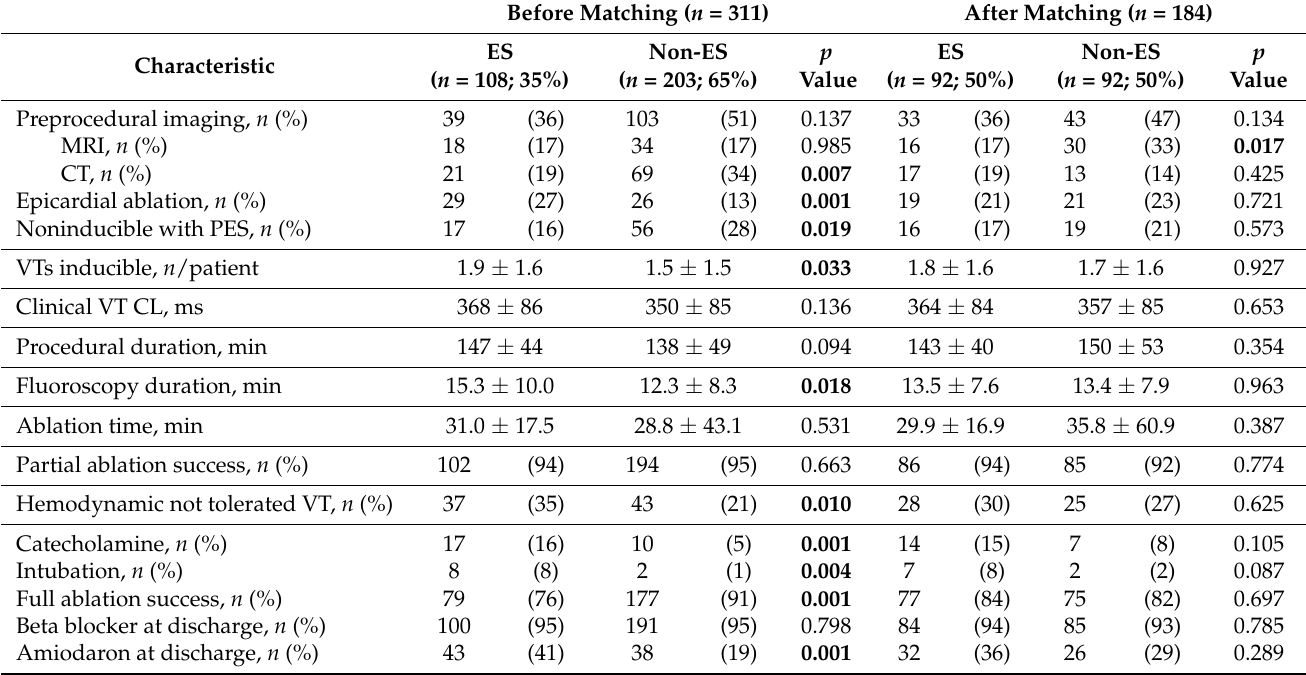
Table 2. Procedural data and intraprocedural